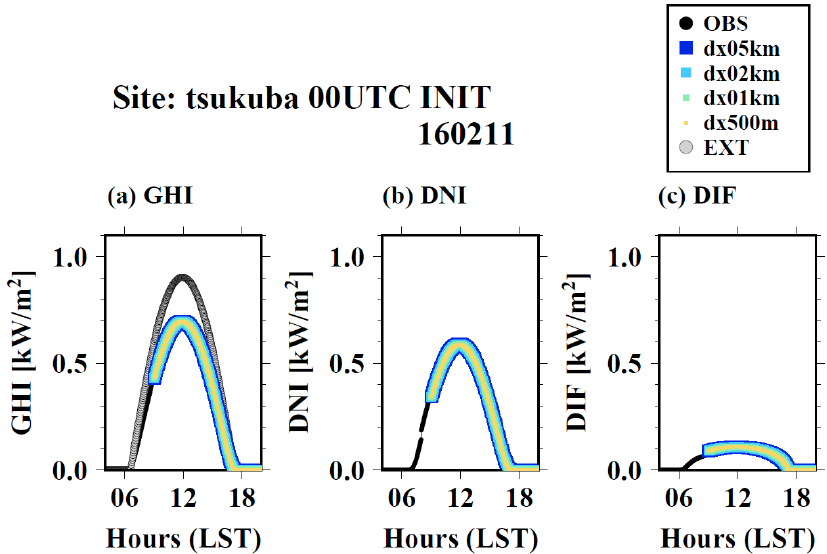
Figure 6. Comparison of ( a ) GHI, ( b ) DNI, and ( c ) DIF time series under clear sky conditions (AOD~0.2) at Tsukuba station on 11 February 2016 for dx05km (blue), dx02km (light blue), dx01km (green), and dx500m (yellow) with 00 UTC (09 JST) initialization time, respectively. Data was plotted every 2.5 min. Black circles indicate observations (OBS) and gray circles indicate extra-terrestrial solar irradiance (EXT).